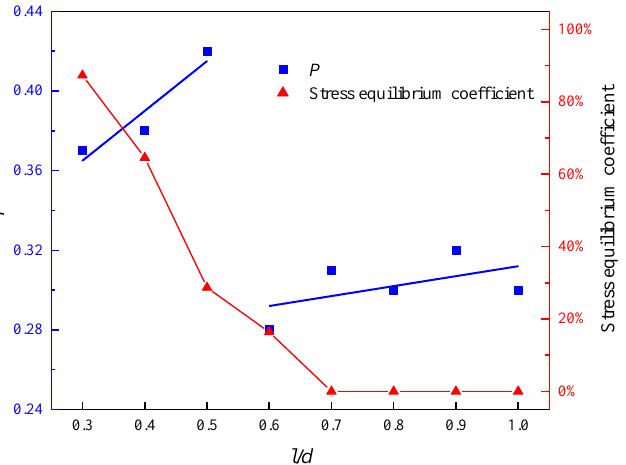
Figure 8. Variation law of energy consumption ratio and stress balance coefficient of coal with different l / d .